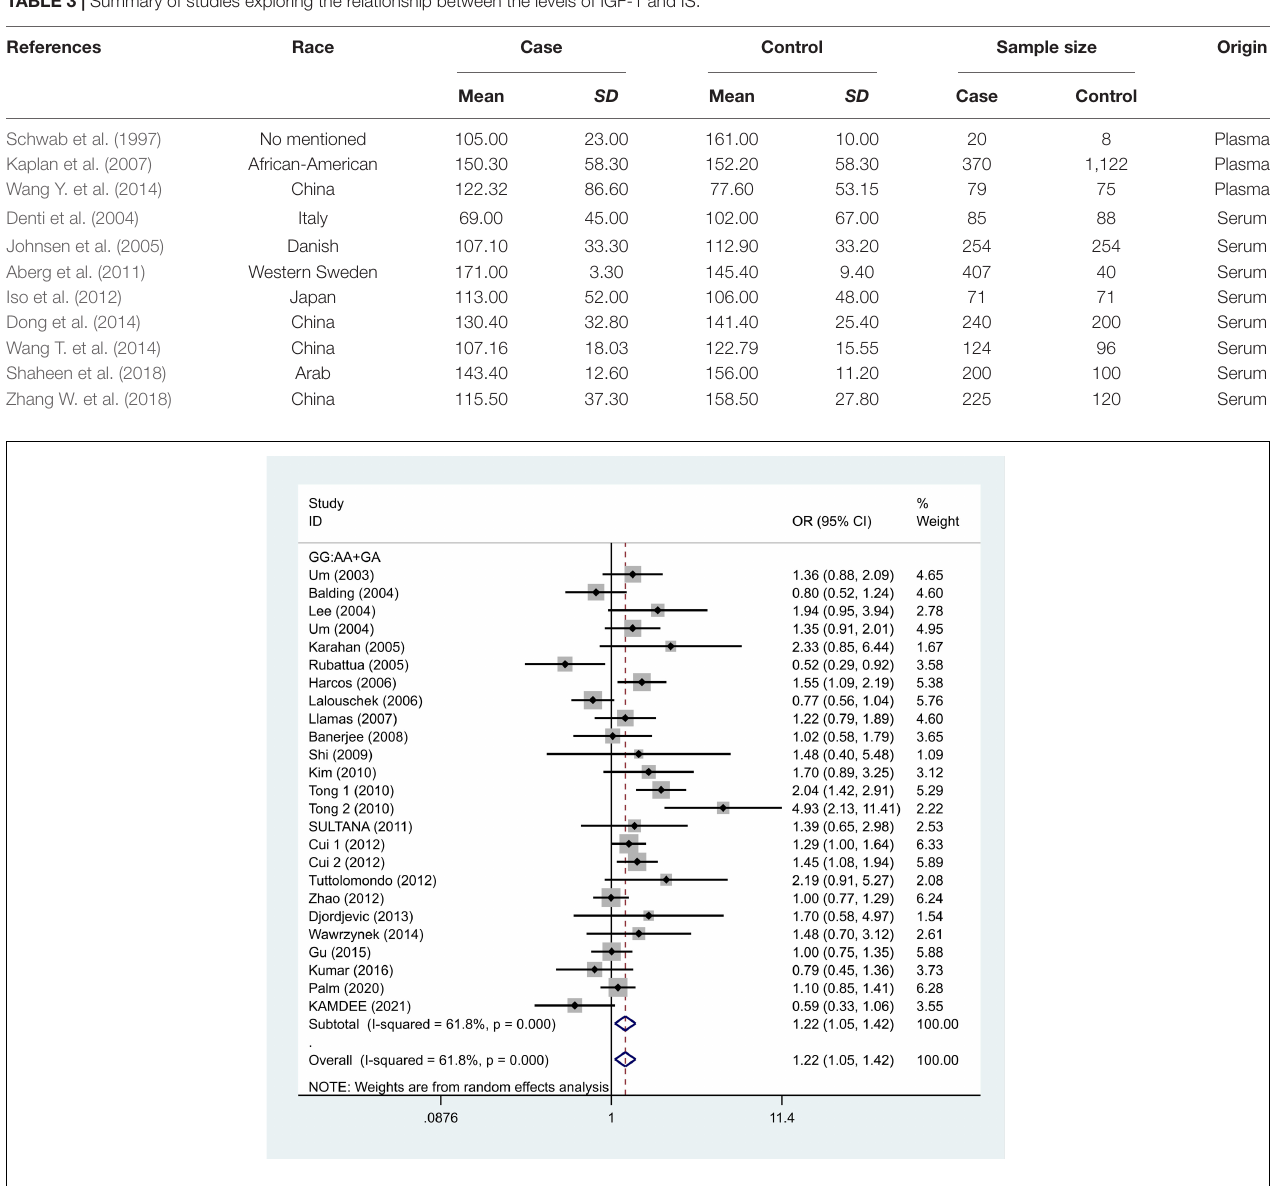
FIGURE 2 | Results of the random-effects meta-analysis for the TNF- α G308A genotype (GG vs. AA + GA) in IS and control